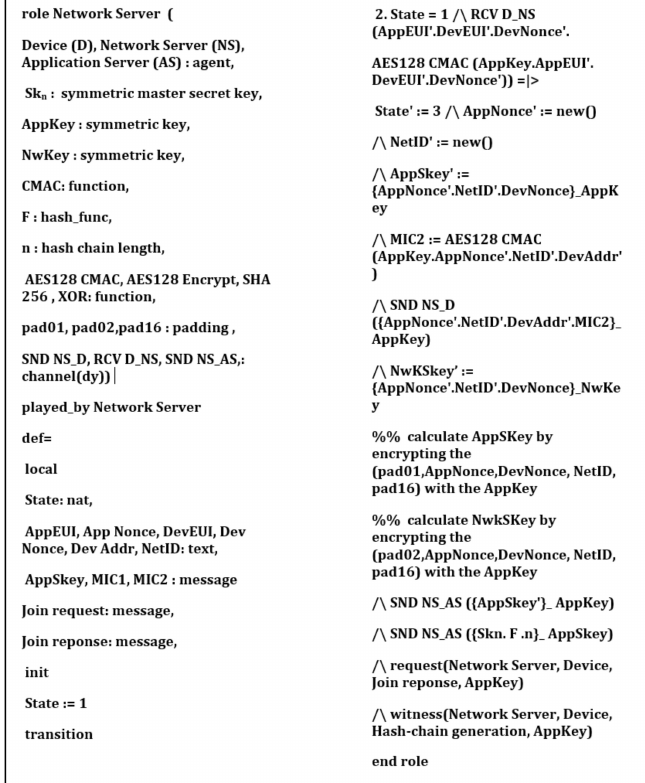
Figure 10. Network server role using HLPSL and AVISPA.